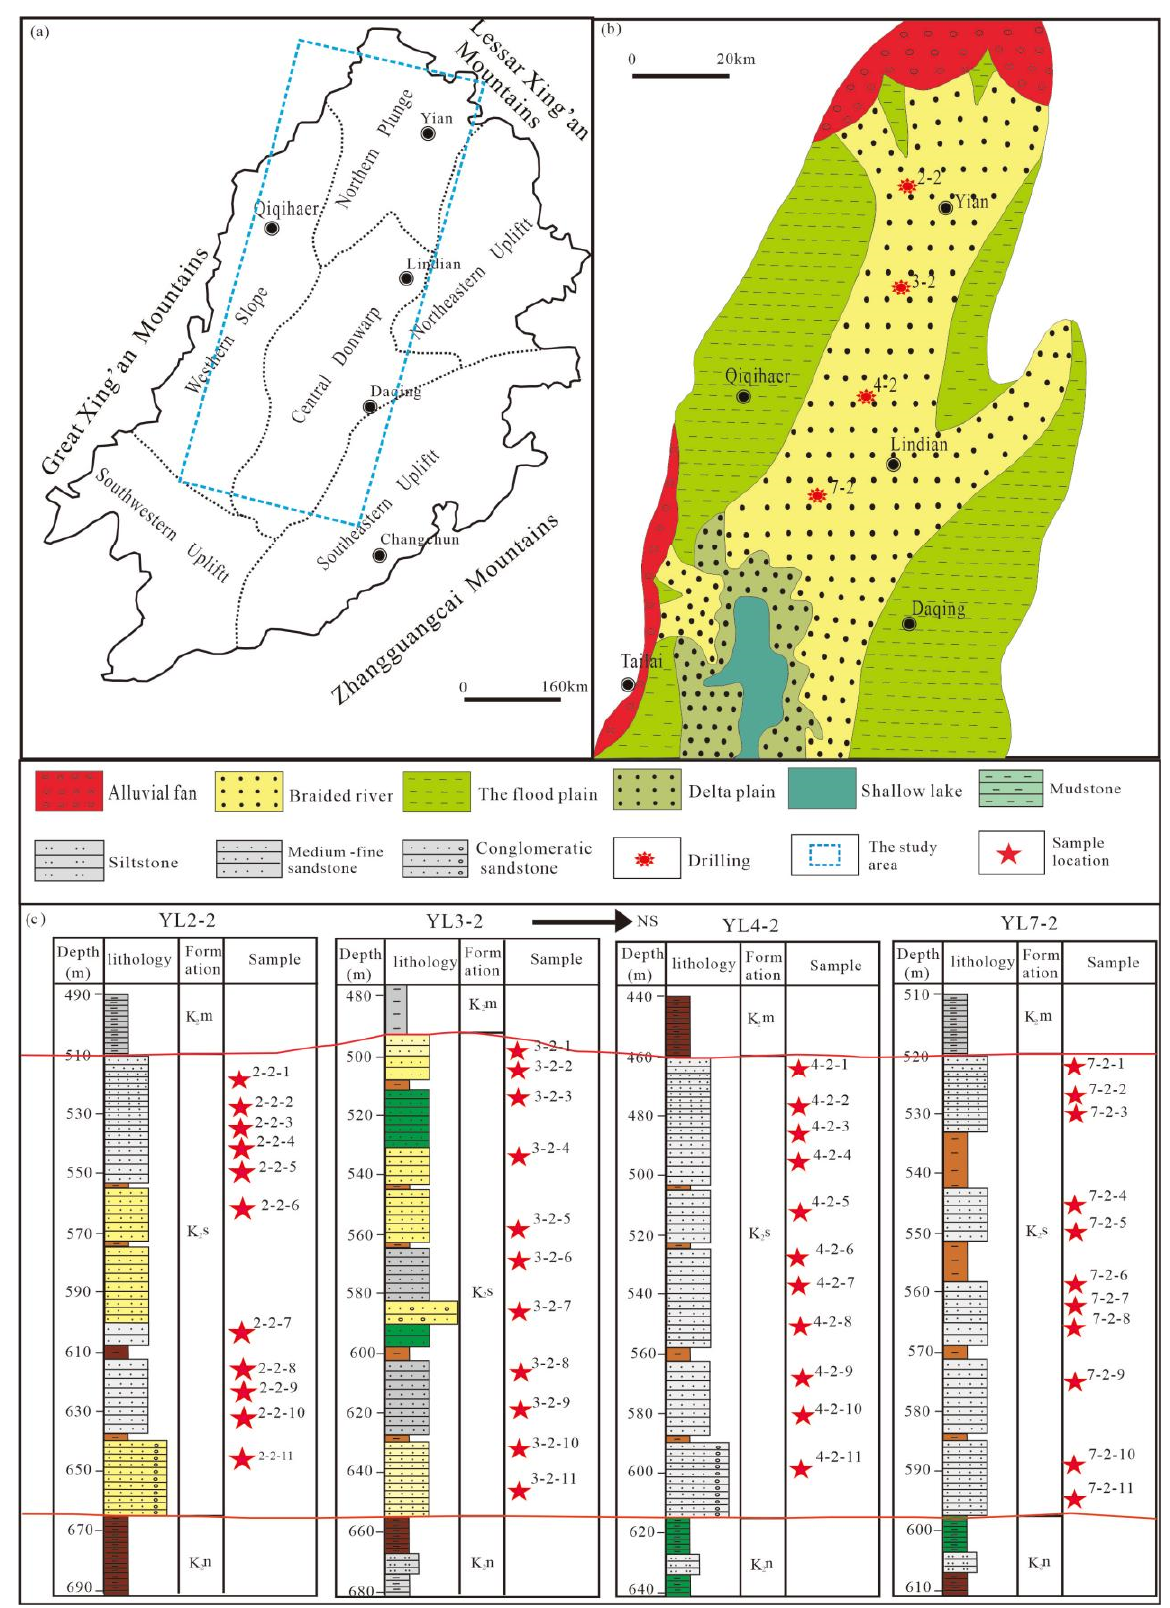
Figure 3. ( a ) Structural partition map, ( b ) sedimentary phase diagram of the Sifangtai Group, ( c ) drilling sampling map of the study area.